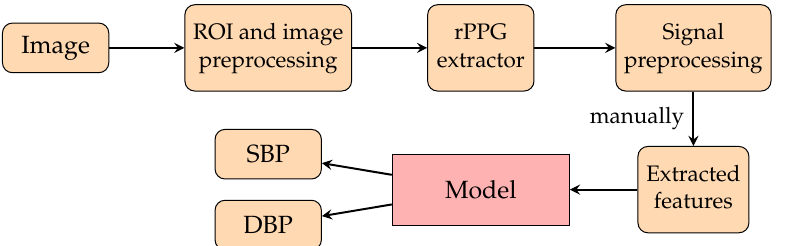
Figure 14. A pipeline of a deep learning model for rPPG singals proposed in [147,229,230]. The pixels of the ROIs of face images are preprocessed and then extracted to form rPPG signals. These rPPG signals are then preprocessed, and those features of preprocessed rPPG signals are extracted to feed the respective models for training to predict SBP and DBP